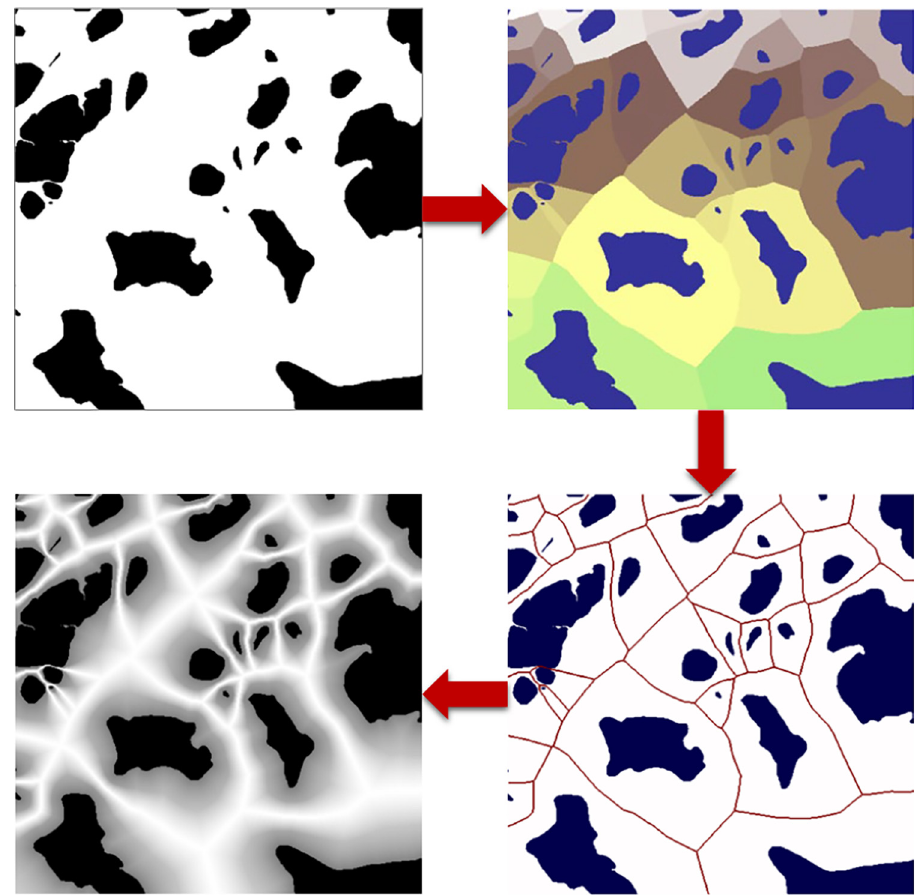
Figure 6 The process of environmental potential fi